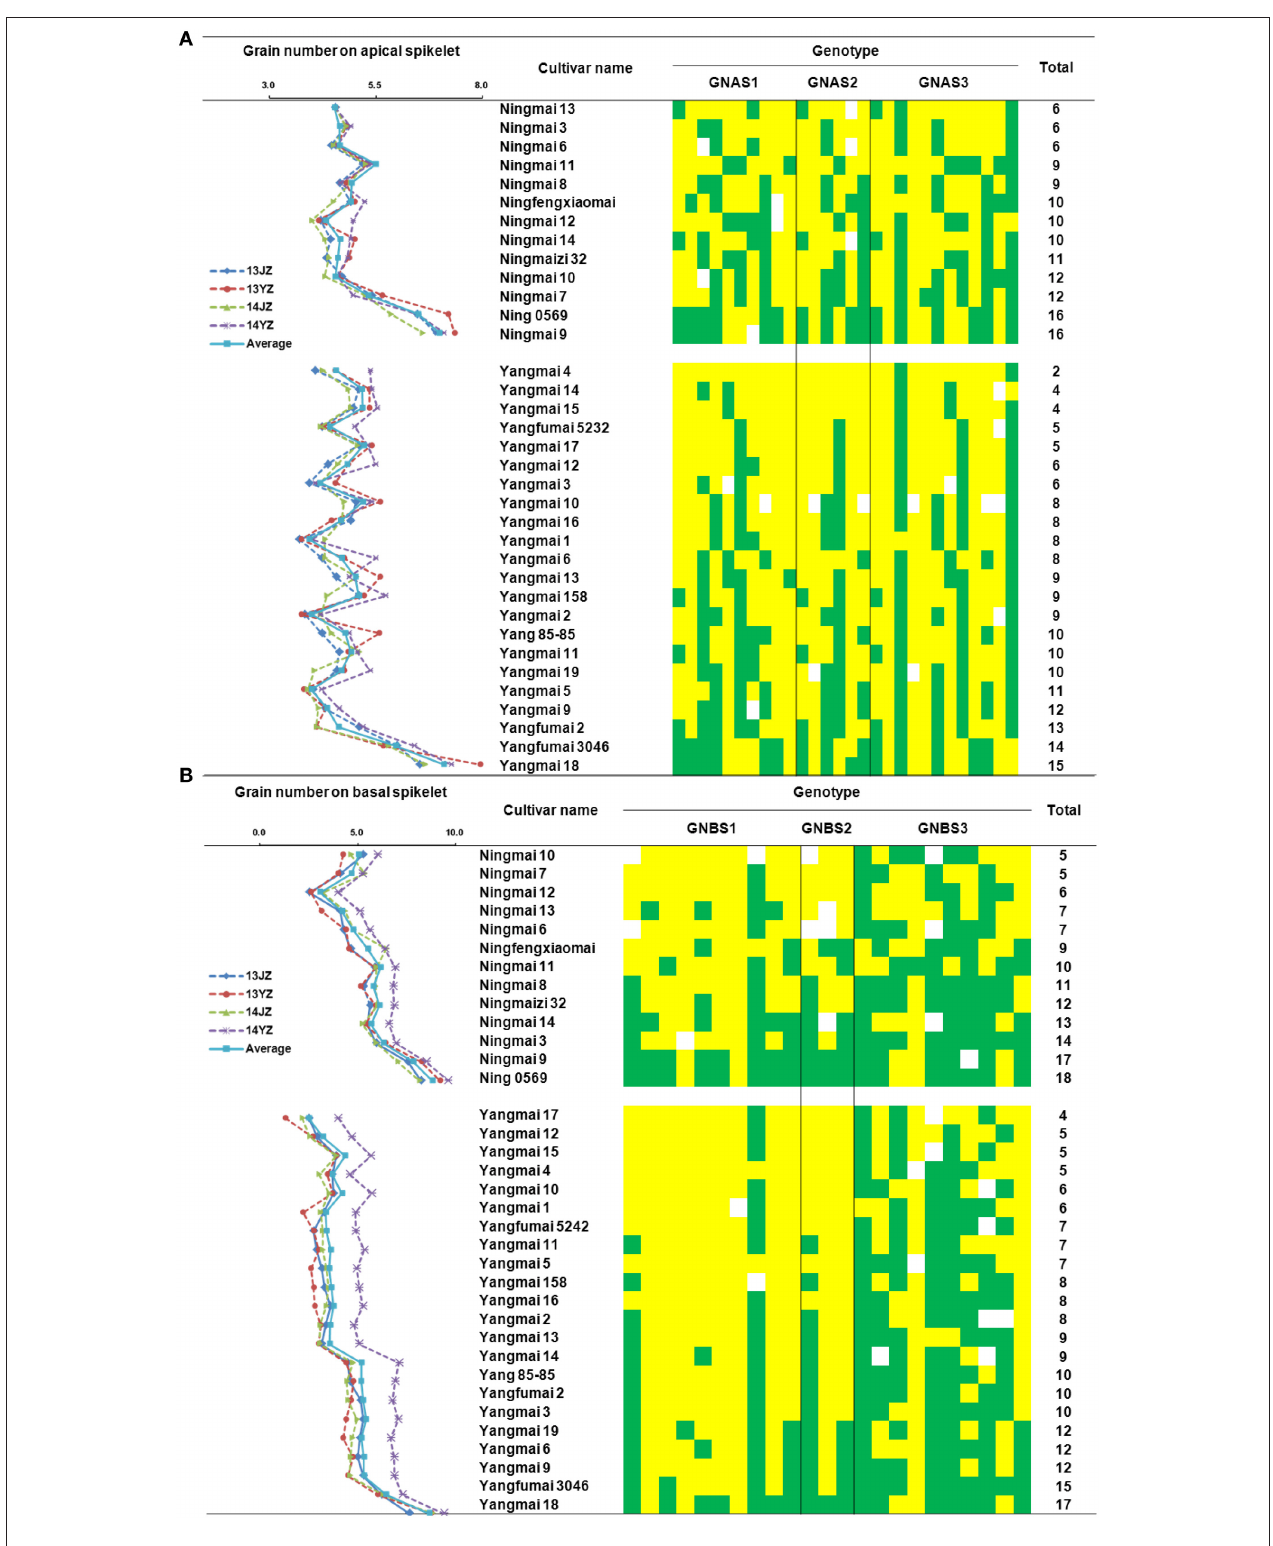
FIGURE 5 | Distribution of favorable alleles associated with grain numbers in apical and basal spikelets in Yangmai and Ningmai varieties. (A) Distribution of favorable alleles associated with grain-setting in apical spikelets in Yangmai and Ningmai varieties. (B) Distribution of favorable alleles associated with grain-setting in basal spikelets in Yangmai and Ningmai